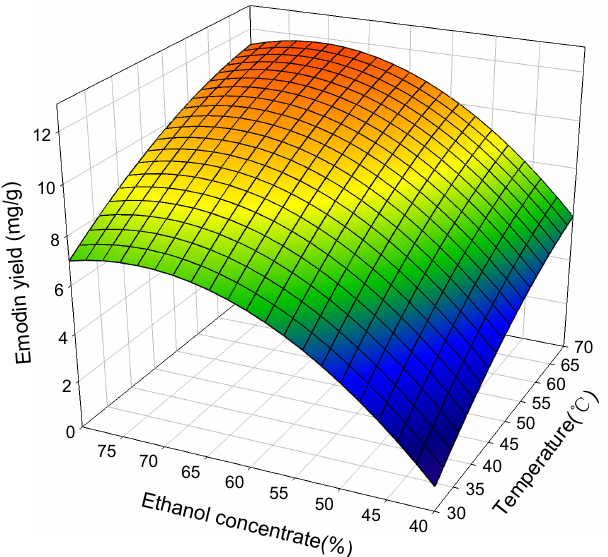
Figure 3. The effect of ethanol concentrate and temperature on the extraction yield of emodin at ultrasonic power of 120 W.